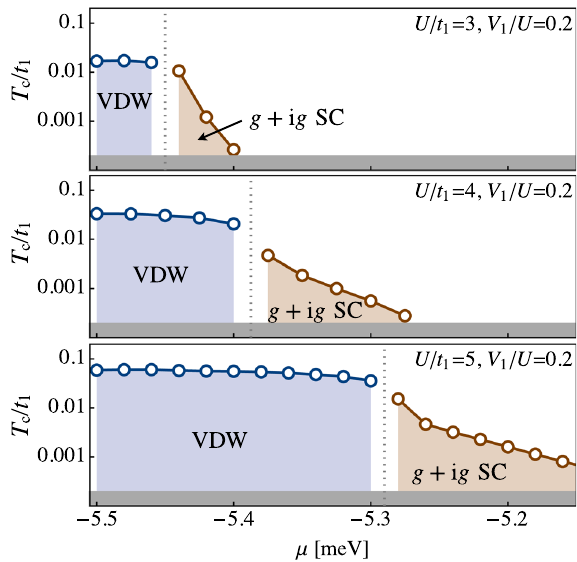
Fig. 5 U dependence. Critical temperature for three values of the on-site interaction U and fi xed V n . The valley density wave (VDW) and g-wave pairing phase ( g + i g ) appear near Van Hove fi lling in all three